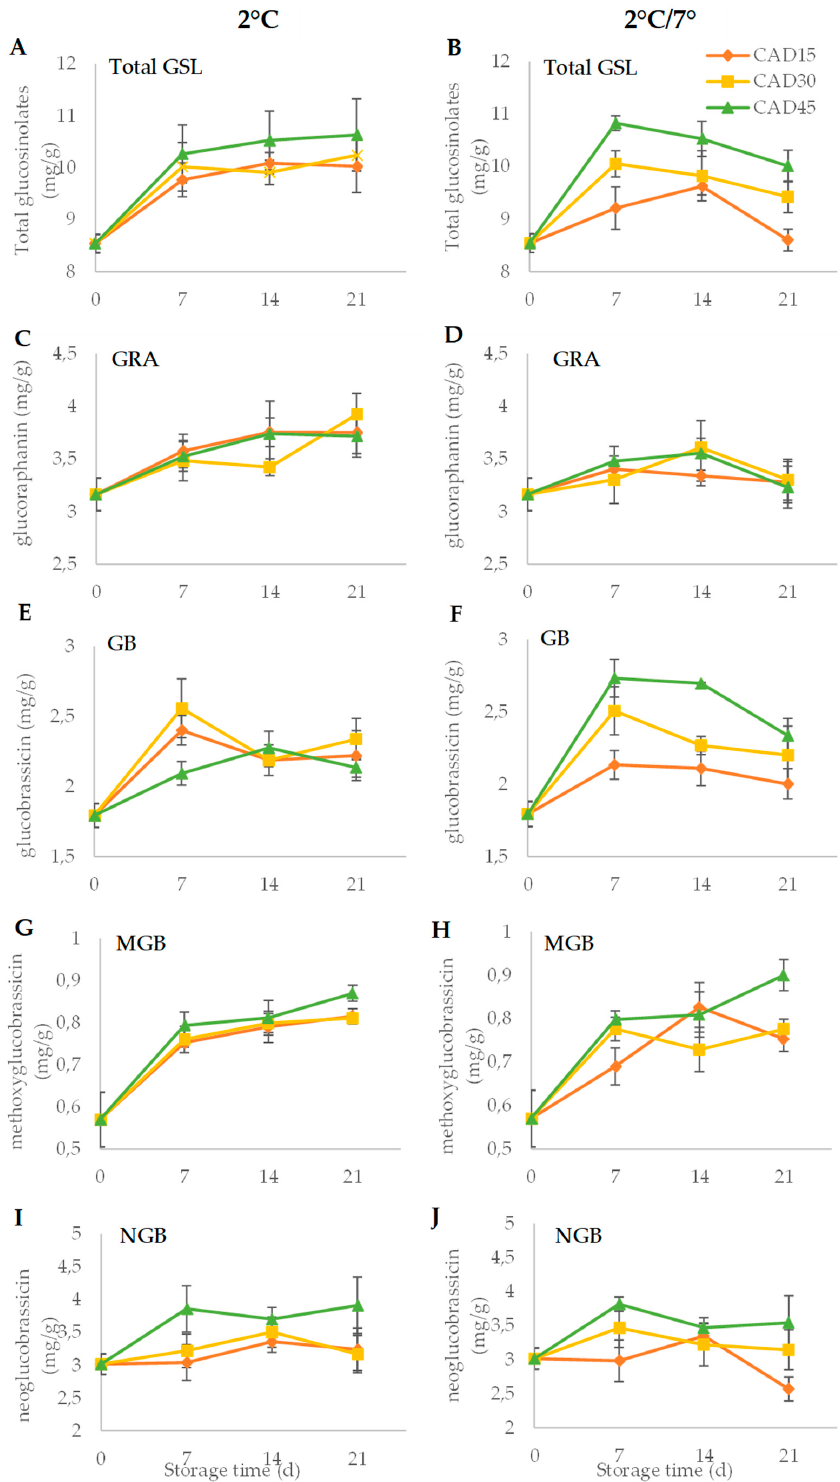
Figure 5. Evolution of total glucosinolate content ( A , B ), GRA ( C , D ), GB ( E , F ), MGB ( G , H ), and NGB ( I , J ) of broccoli florets packaged in films with different levels of micro-perforation (CAD15, CAD30 and CAD45) stored at 2 ◦ C and 2 ◦ C/7 ◦ C. Vertical bars represent standard error (n =